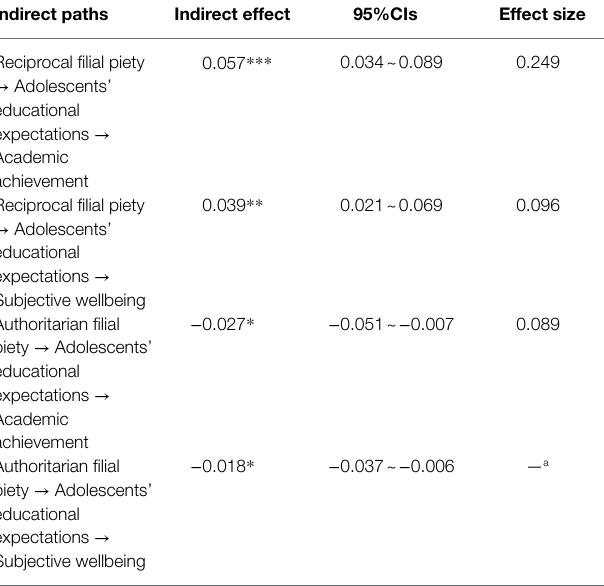
TABLE 2 | Testing mediation using bootstrapping